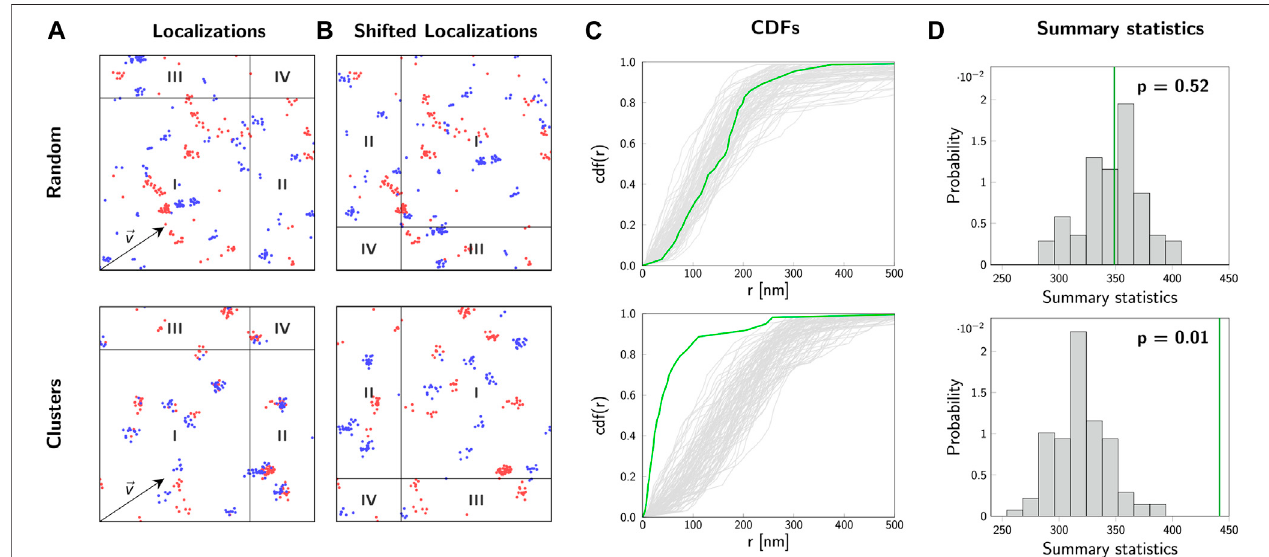
FIGURE 5 | 2-CLASTA method. Analysis of localization maps with 2-CLASTA. (A) Simulated two-color localization maps for a random (top) and a clustered (bottom)distributionofbiomolecules.Imagesshowa2×2 μ m 2 region.ForthesimulationofblinkingweusedexperimentaldataobtainedforSNAP-AF488(bluechannel) and SNAP-AF647 (red channel). (B) Shifting all localizations of the blue color channel by the shift vector (cid:2) v breaks correlations between the two color channels. (C) The CDFofcross-nearestneighbordistances, r ,betweenthetwocolorchannelsisplottedingreenforthelocalizationdatashowninpanel (A) .Thefunctionscdf rand ( r )of n = 99 control curves, generated with randomly chosen toroidal shifts, are depicted in light gray. (D) As a summary statistics, the integral of the CDFs was calculated. Basedontherankofthesummarystatistics s